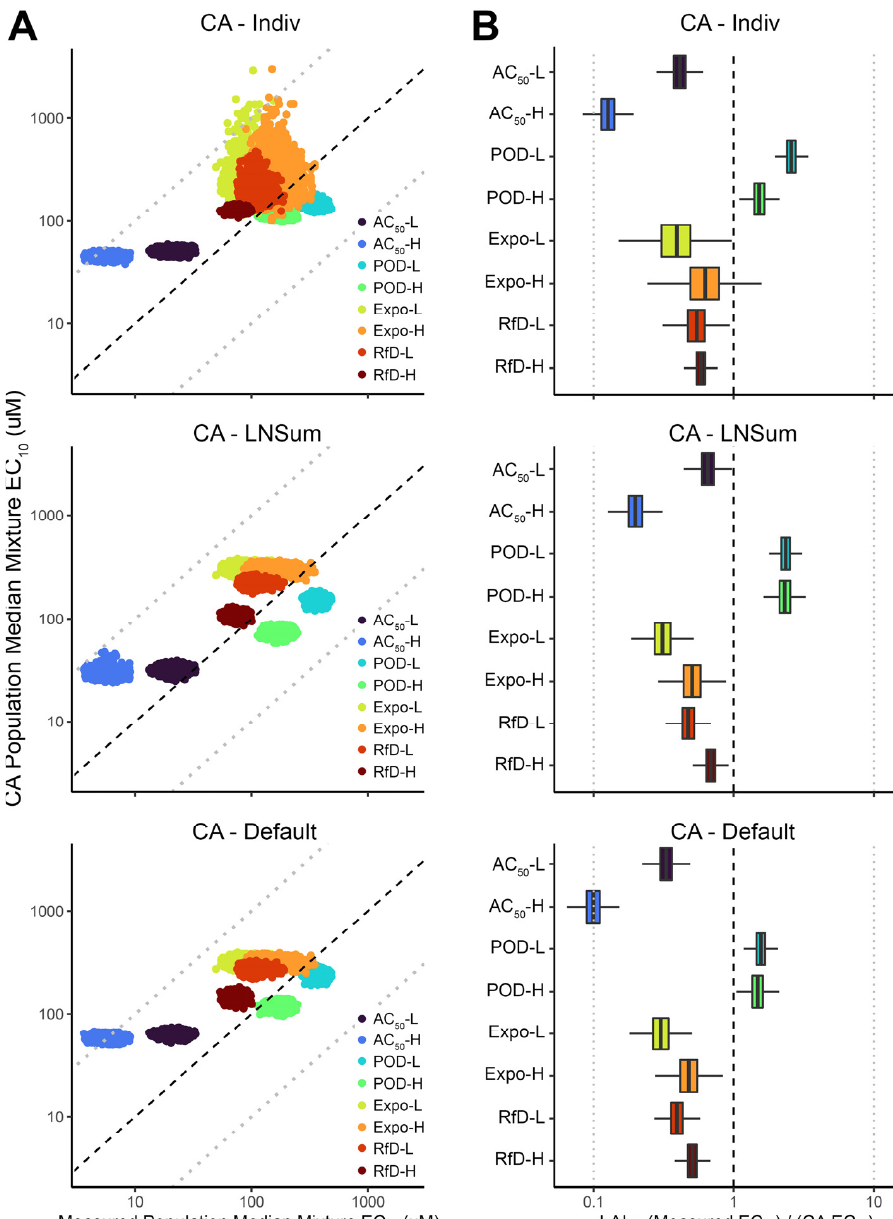
Figure 3. Comparison of mixtures’ points of departure (POD = EC 10 ) measured and predicted by different concentration addition (CA) approaches for the population median individual. ( A ) Scatter plot of Bayesian posterior samples of measured and CA-predicted EC 10 for the population median individual. ( B ) Posterior distribution of Loewe Additivity Index (LAI) for each mixture for the population median individual, where LAI < 1 indicates greater-than-additive effects (“synergy”) and LAI > 1 indicates less-than-additive effects (“antagonism”). In both panels, dashed line indicates equality, and light dotted lines indicates 10-fold differences in either direction. See Materials and Methods and Figure 1 for details as to the different CA approaches CA Indiv , CA LNSum , CA Default